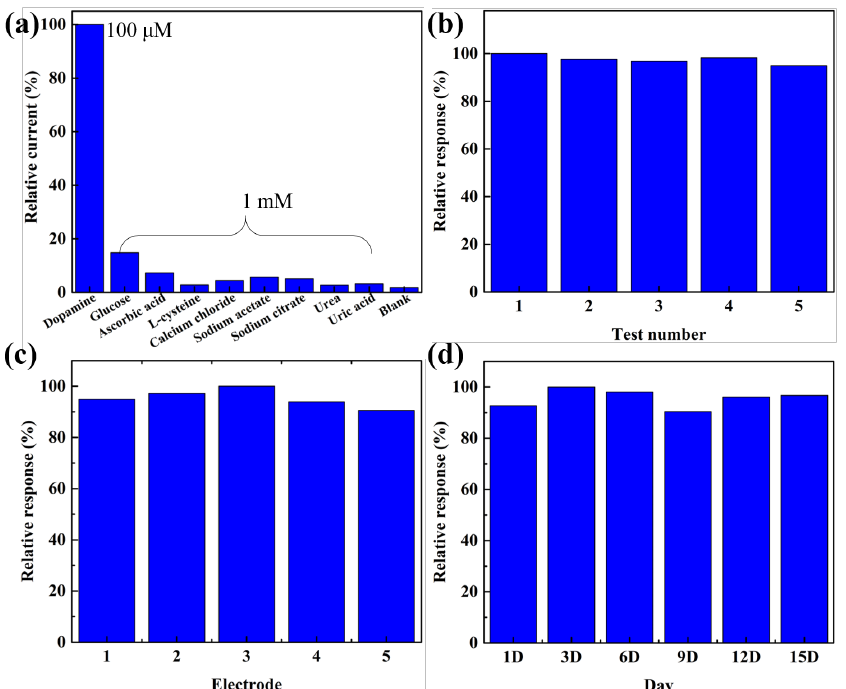
Figure 10. ( a ) Selectivity of the BT/rGO-modified electrode in the presence of dopamine (100 µM) and interfering materials (1 mM). ( b ) Repeatability, ( c ) reproducibility, and ( d ) storage stability analyses of the BT/rGO-modified